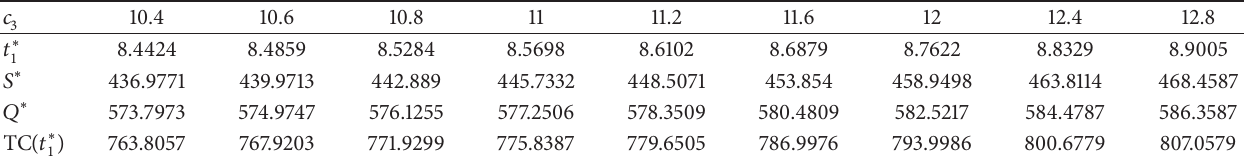
Table 6: The sensitivity of 𝑐 3 for the models in Example 1.